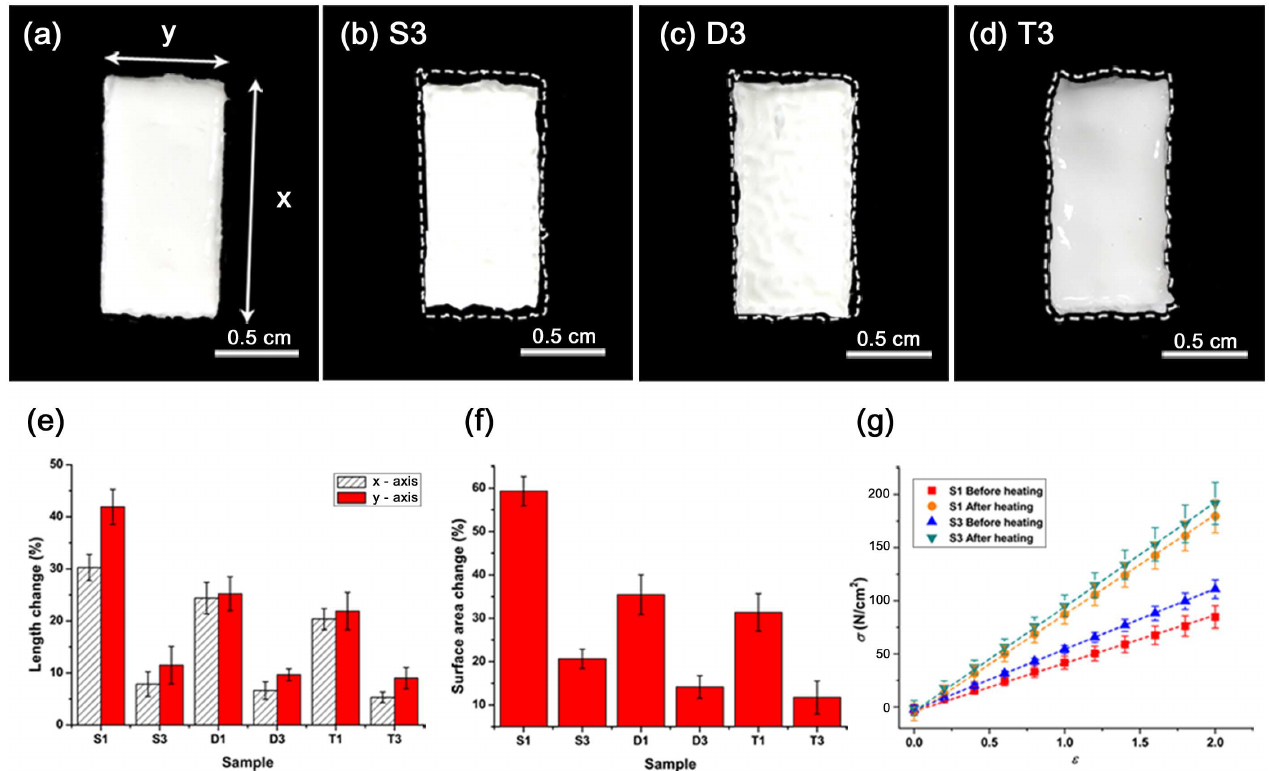
Fig 2. Homogeneous PNIPAAm structuresshrink in response to heat. (a) The homogeneous PNIPAAm structures have the same size at the beginning.The fabricated PNIPAAm structures with 3 mg cross linker as single (b) , double (c) and triple (d) layers are shown. After heating, single (b) , double (c) and triple (d) layers shrink in every direction. White dash lines indicatethe initial size of each structure. The fabricated structures do not bend, but shrink. (e) Length changesin length in the x- and y-directions for different PNIPAAm structures were depictedas a graph. S1 (single layer with C1 cross linker. Other structures are namedwith the same rule.) shows the most significantstructural changeand the T3 exhibits least change. (f) Surface area changesof S1, S3, D1, D3, T1 and T3 were measuredand depicted as a graph. Like length variation, S1 shows the biggest changeand T3 shows the least change. (g) Young’smoduli of S1 and S3 change in responseto heatingdepictedas graph. The Young’s modulus of dense S3 is higherthan that of S1. Since heatingincreasesthe stiffness of PNIPAAm, the Young’smodulusalso